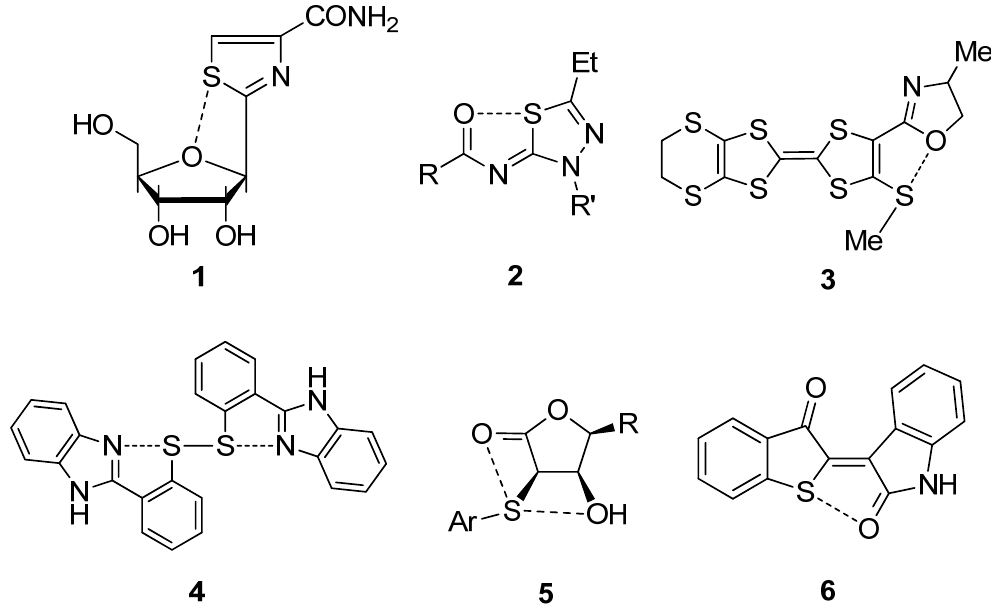
Figure 3. Examples of S···O interactions in organic